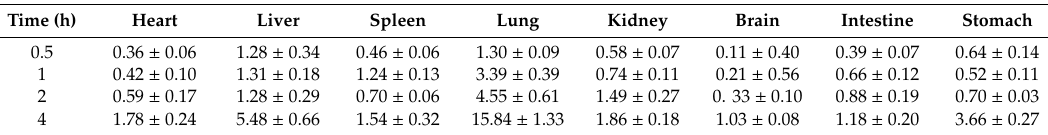
Table 6. Plasma to tissue partition coefficients (Kp) of alnustone after i.v. administration of alnustone (5 mg / kg) to the rats (Mean ± SD, n = 5).